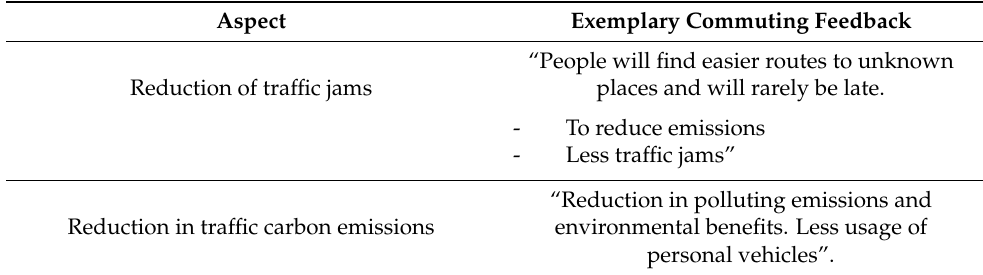
Table 6. Impact of the multimodal travel guidance system on commuters’ travel